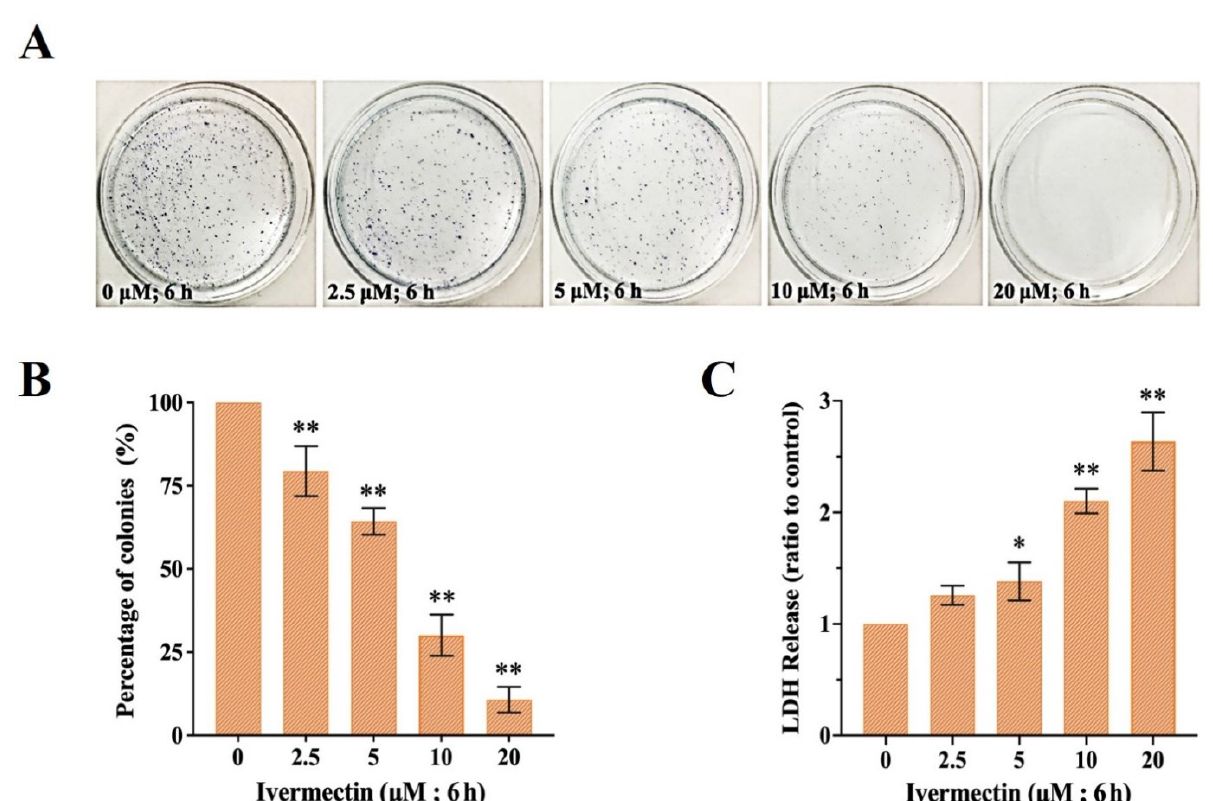
Figure 1. IVM induces cytotoxicity in RAW264.7 cells. ( A ) Colony formation of cells after IVM treatment of cells for 6 h. ( B ) The number of colonies was significantly decreased in cells treated with IVM for 6 h. ( C ) Release rate of LDH in the treatment of various concentrations of IVM for 6 h. Data were expressed as means ± SD (standard deviation) of three separate sets of independent experiments. * p < 0.05, ** p < 0.01 and indicate the significant differences from the control.